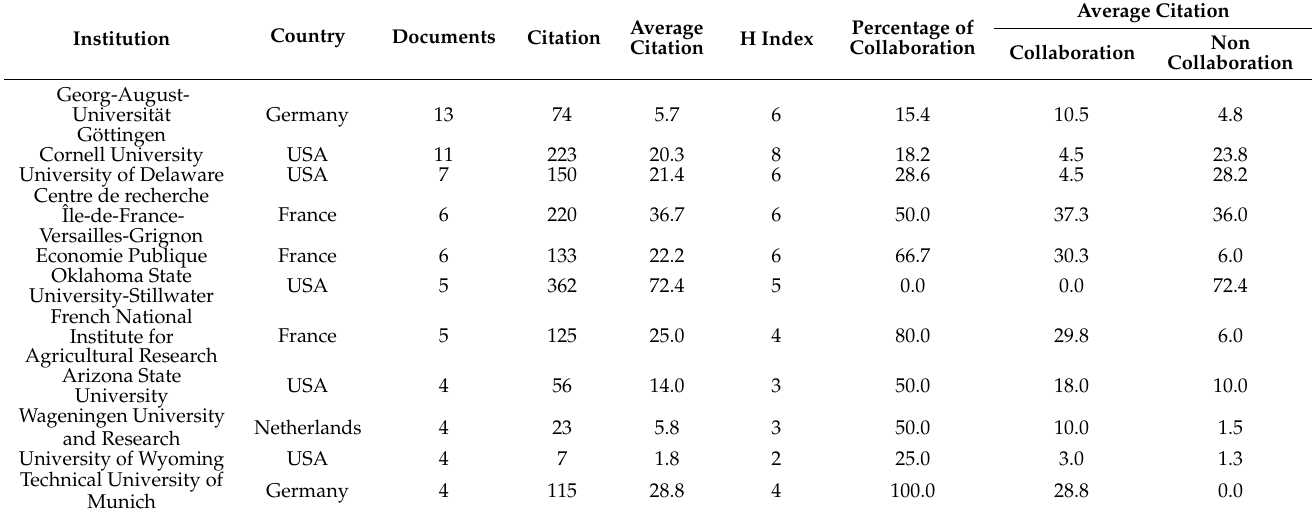
Table 6. Major characteristics of the most active institutions related to EEA